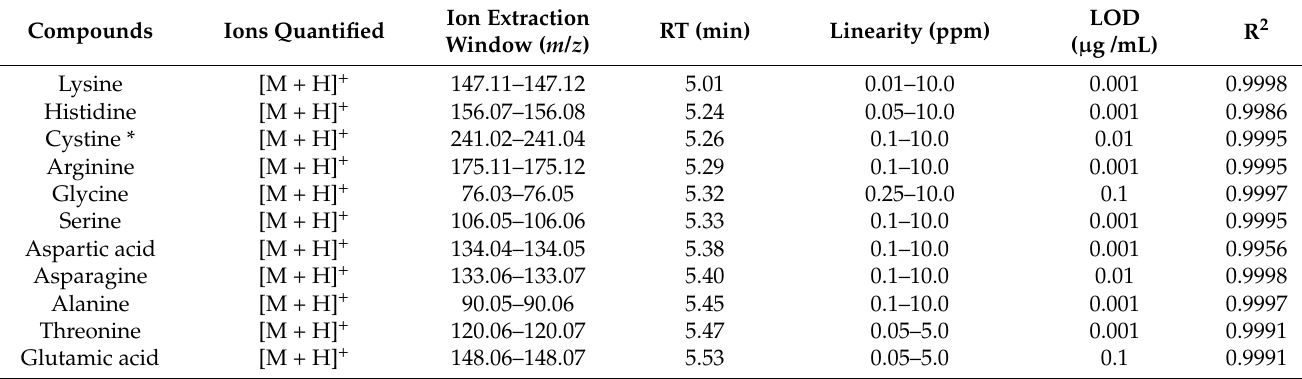
Table 2. LOD, linearity range ( ≤ 5 ppm), and retention time of quantitated amino